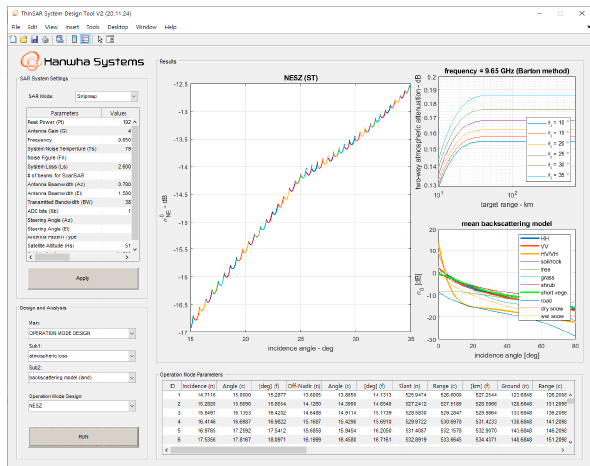
Figure 21. System design tool of the S-STEP SAR payload.